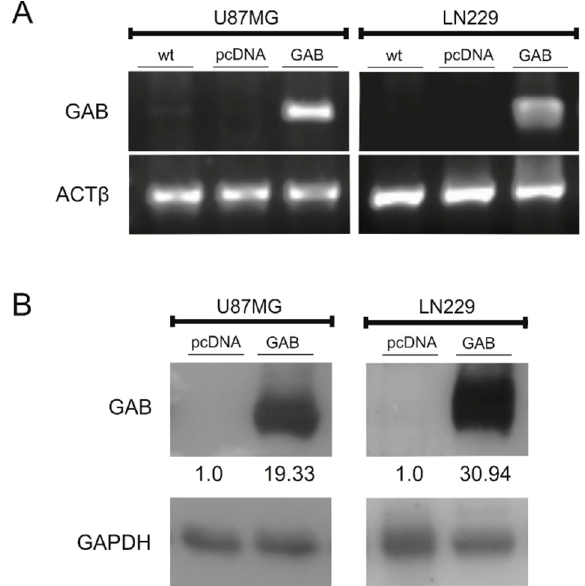
Figure 1. Analysis of the GAB levels in U87MG and LN229 cells wild-type (wt) or stably transfected with an empty pcDNA3 vector (pcDNA) or a pcDNA3 vector carrying GAB sequence (GAB). ( A ) GAB and ACT β transcripts were determined by RT-PCR. ( B ) Protein levels of GAB and GAPDH in whole-cell lysates were determined by a Western blot analysis. A rabbit anti-GLS2 antibody detecting both isoforms arising from the GLS2 gene was used.